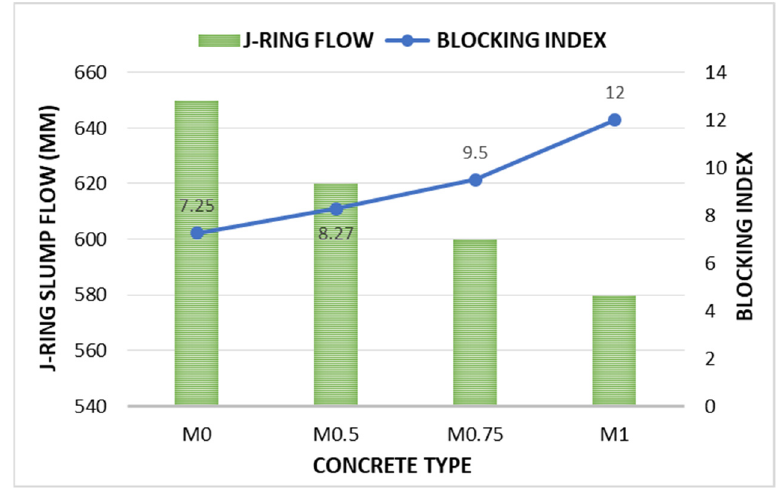
Figure 7. J-ring flow and blocking index parameter for various types of SCC mixes.